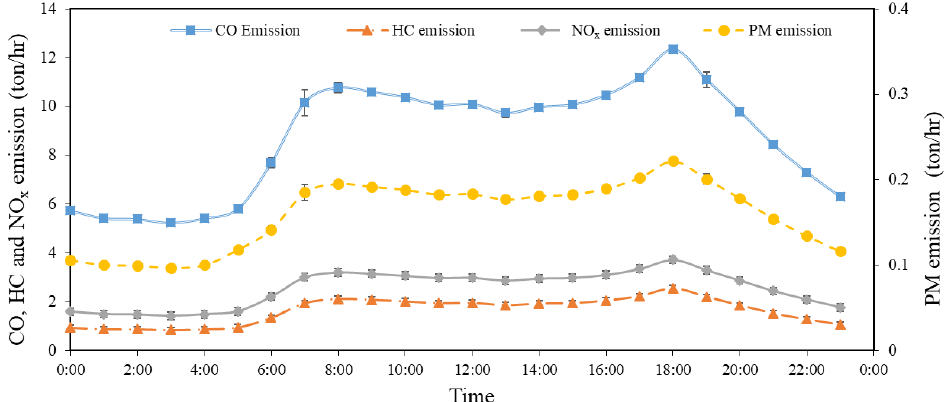
Figure 8. Diurnal distribution of traffic emissions in Bangkok during weekdays.